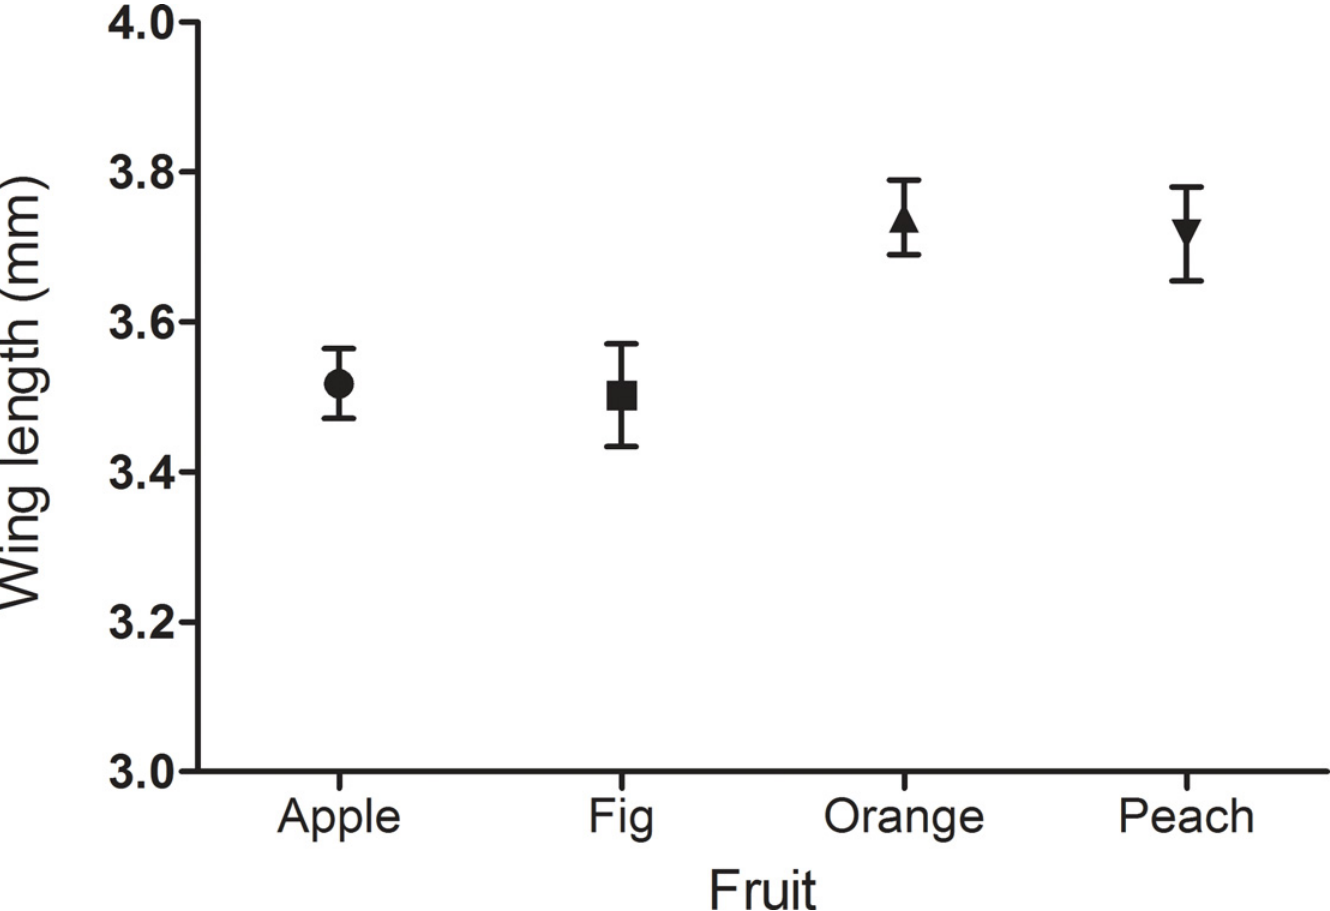
Fig 6. Effect of fruit species on parasitoid size. Mean wing length of Diachasmimorpha longicaudata reared on Ceratitis capitata larvae that developed in different host fruit. Bars show the standard error of the mean.